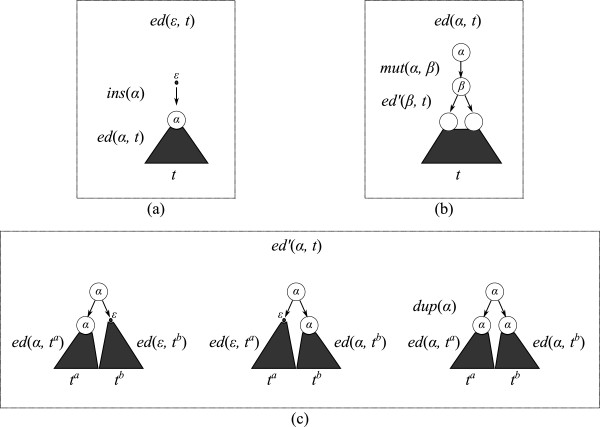
Edit distance computation for the case where the source string is either empty or contains a single letter. Charts (a), (b) and (c) exemplify Equations 1, 2 and 3, respectively.